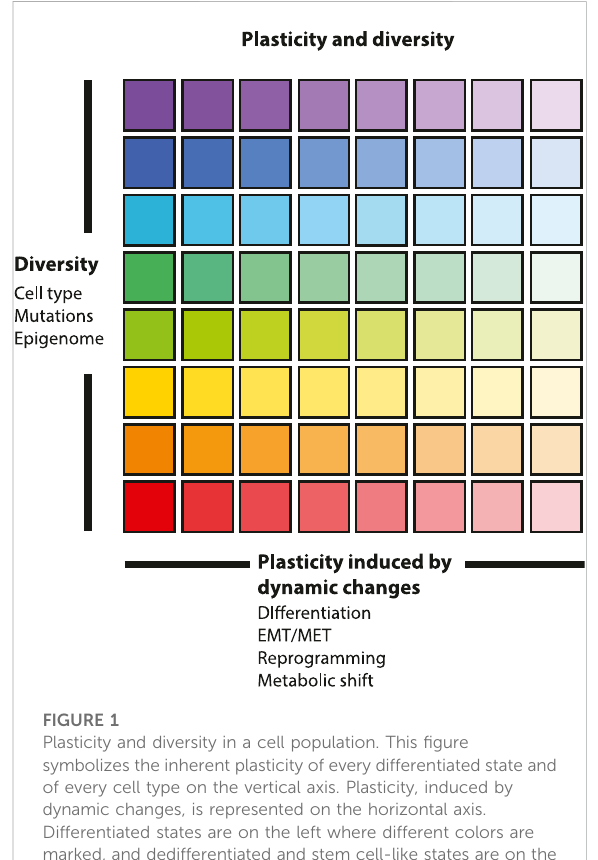
FIGURE 1 Plasticity and diversity in a cell population. This fi gure symbolizes the inherent plasticity of every differentiated state and of every cell type on the vertical axis. Plasticity, induced by dynamic changes, is represented on the horizontal axis. Differentiated states are on the left where different colors are marked, and dedifferentiated and stem cell-like states are on the right where colors are light. Cell diversity includes cell identity, mutations and epigenetic landscape of cells creating cellular heterogeneity. Plasticity is triggered by external signals from the tumor microenvironment and is exhibited in the varying response ofcellsdependingoncellstateandlocation,thuscreatingavariety of phenotypic